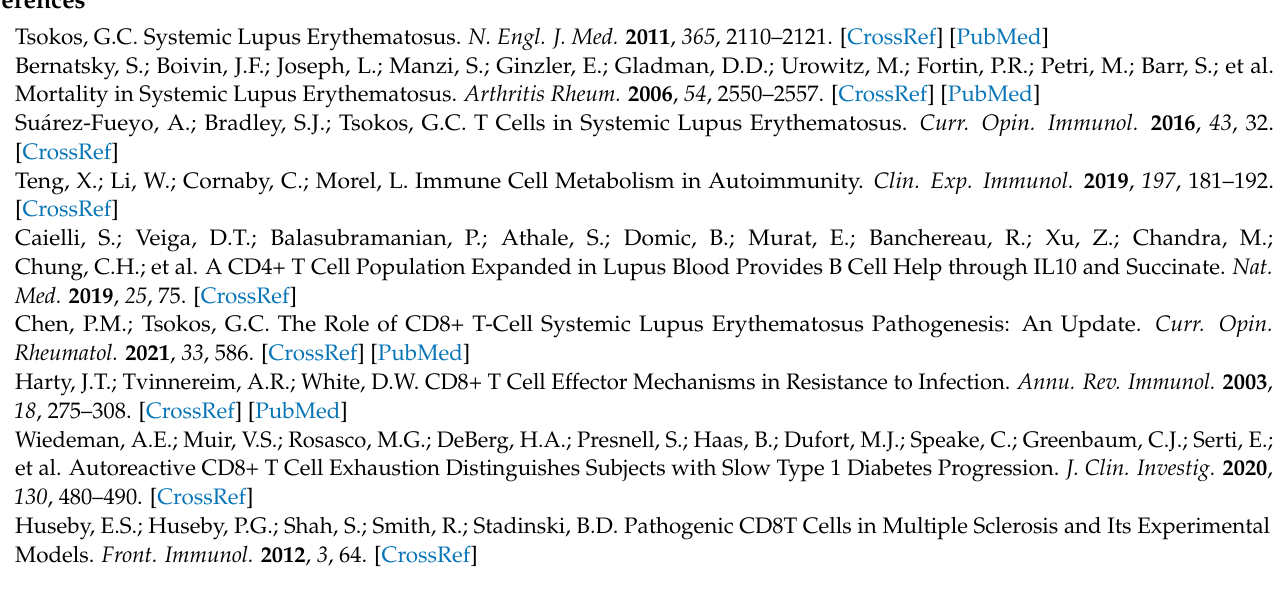
the study. Figure S1: Gating strategy to assess surface markers from whole blood of SLE patients and healthy controls. Figure S2a: Percentage of CD8 + T cells in PBMCs of SLE patients. Figure S2b: Percentage of purity of CD8 + T cells after isolation. Figure S2c: Gating strategy to determine naïve, effector and memory compartments of CD8 + T cells. Figure S3: Gating strategy to determine transcription factor and cytokine staining from CD8 + cells of SLE patients and healthy controls. Figure S4: Gating strategy to determine transcription factors from both SLE and healthy controls from PBMCs. Figure S5: Gating strategy to determine cytotoxic and inflammatory cytokines from both SLE and healthy controls from PBMCs. Figure S6a: Gating strategy to determine cellular ROS in CD8 + T cells of both SLE patients and healthy controls Figure S6b: Gating strategy to determine mitochondrial hyperpolarization in CD8 + T cells of SLE patients and healthy controls. Figure S7: Gating strategy to determine phospho-STAT proteins from CD8 + T cells of SLE patients and healthy controls. Figure S8: Gating strategy to determine phospho mTOR proteins from CD8 + T cells of SLE patients. Figure S9: Gating strategy to determine Cytotoxic and inflammatory molecules from Tc1 and Tc21